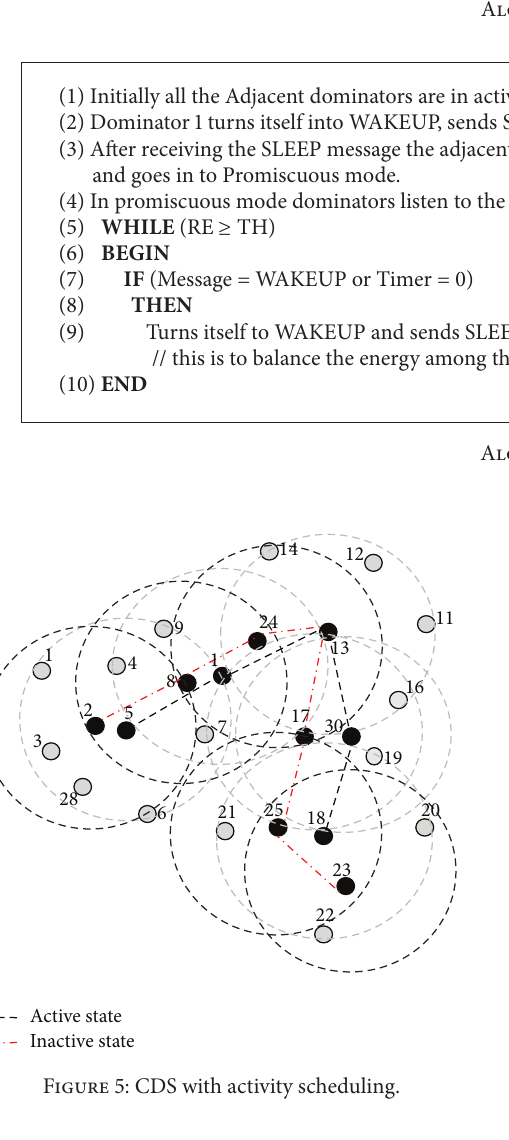
in Figure 6. Nodes {(2, 5), (1, (8, 24)), (17, 30), (18, (23, 25))} perform activity scheduling locally. BLACK slashed lines (active connection) and RED slashed lines (inactive con- nection) indicate the scheduling. When compared to